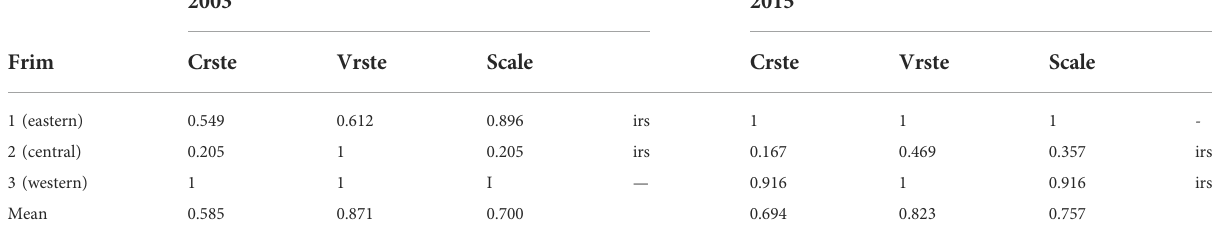
TABLE 3 Ef fi ciency values of rural land outsourcing in China in 2003 and